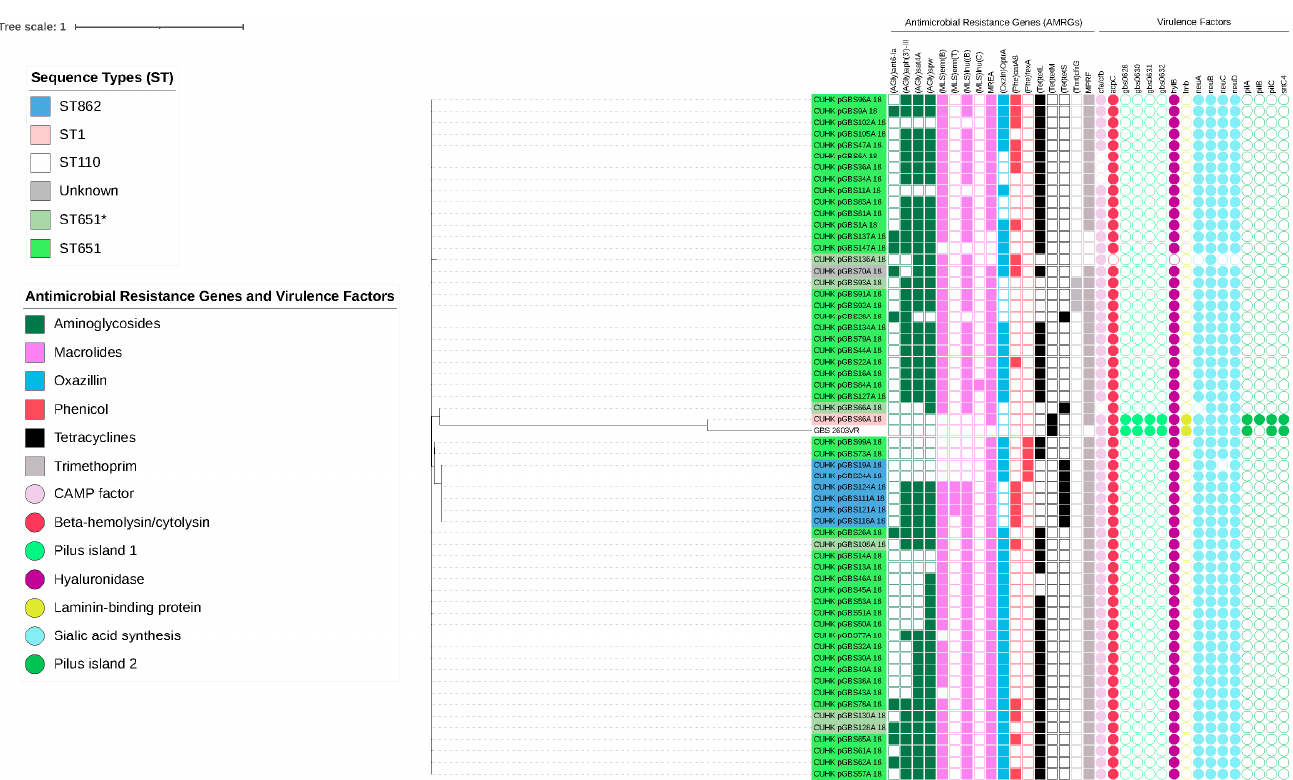
Figure 3. Phylogeny of pig GBS profiles’ molecular characteristics. Coloured ribbons on the labels indicate the sequence type; antimicrobial resistance genes and virulence factors are noted in squared boxes and circles, respectively. Sequence types with an asterisk (*) indicate strains with locus variants of the sequence types (SLV/DLV/TLV).